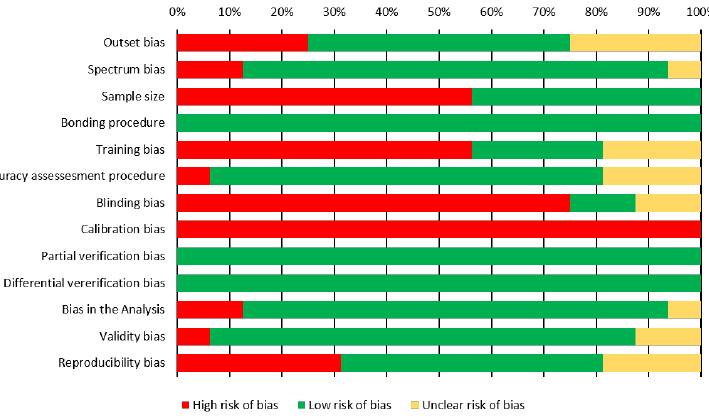
Figure 2. Overview of the overall RoB among different domains and items.